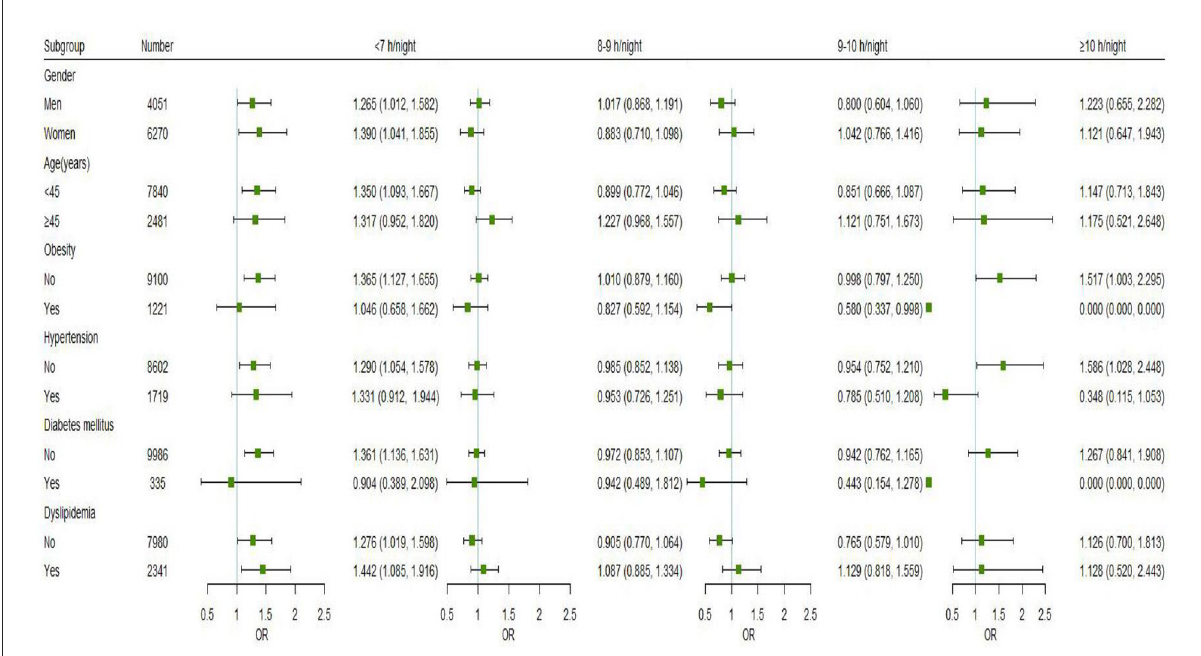
FIGURE3 Subgroup analyses of the associations between nocturnal sleep duration and the risk of hyperuricemia were performed using logistic regression models based on gender, age, and chronic conditions (hypertension, dyslipidemia, DM, and obesity). All models were adjusted for marital status, education level, annual household income, work intensity, sedentary time, position levels, participating in physical exercise, smoking, drinking, having mood symptoms, irregular meal habits, midnight snacks, using hypnotics, nap duration, and were adjusted for gender, age, obesity, DM, hypertension, and dyslipidemia as appropriate. Point estimates for odds ratios are shown as small squares, while the 95% CIs are shown as horizontal lines. The small green squares represent sleep duration of < 7 h/night, the blue represents sleep duration of 8–9 h/night, the red represents sleep duration of 9–10 h/night, and the black represents sleep duration of ≥ 10